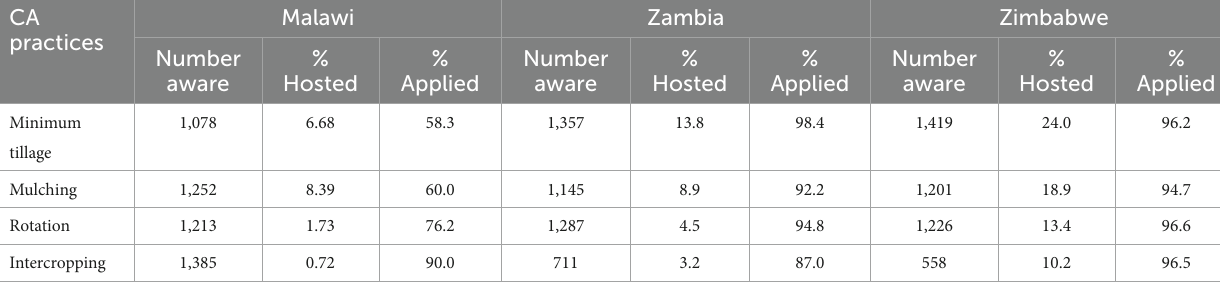
TABLE 8 Hosted demonstration of CA practices and applied the practice in non-demo plots (% of households). CA